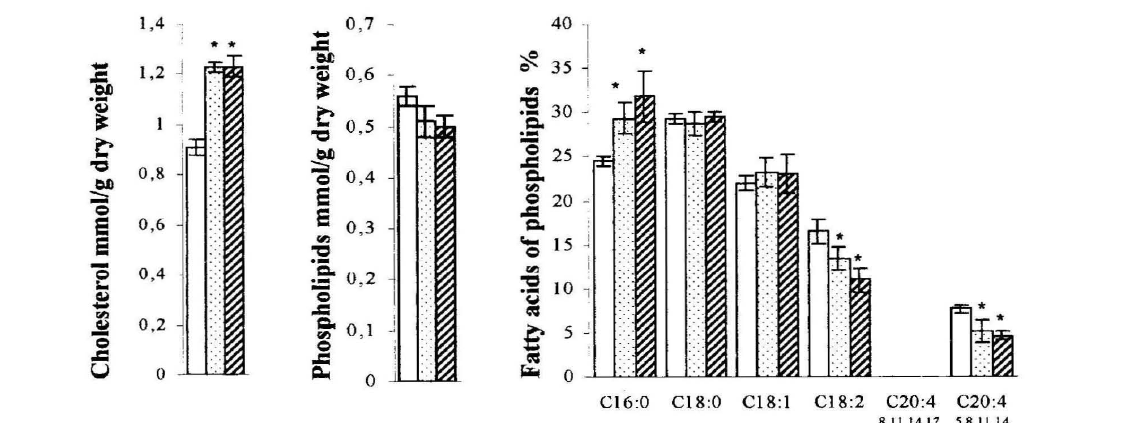
Figure 1. Concentrations (mean±S.D .) of cholesterol and phospholipids as well as fatty acid content of phospholipids (in percent; mean±S.D .) in controls (open bars) and in samples with 2.2 nmoljg wet weight anthranilic lcid (dotted bars) and in samples with 4 nmoljg wet weight anthranilic acid (hatched bars). Samples of rat liver tissue hOl11ogen.ltes were used to test for phospholipid biosynthesis in viTro. Incubation medium: Krebs - Ringer - phosphate buttel' containing 0.3% albumin (pH= 7.4), fatty acid mixture and glycerol. Samples were incubated twice for 4 h at 37()C. "The changes are statistically significant (p<O.OS -p < O.OOl). Ptnidines / Vol. 10 / No.